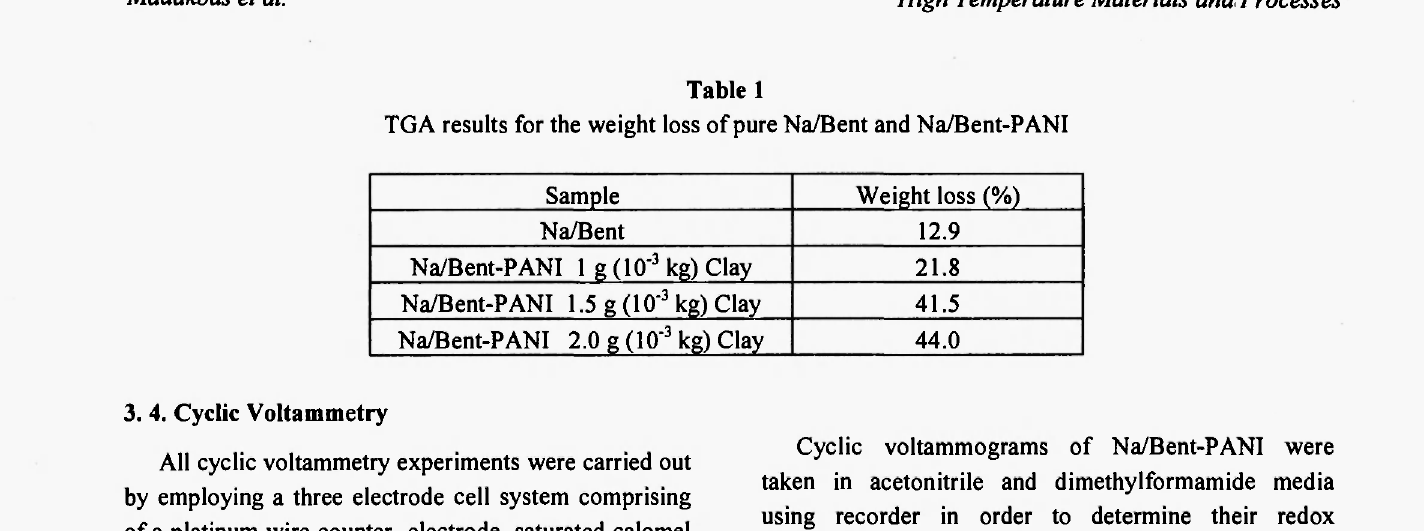
Cyclic voltammograms of Na/Bent-PANI were taken in acetonitrile and dimethylformamide media using recorder in order to determine their redox potentials. 4 shows multiple-cycled voltammograms of the solution recorded in the potential range 0.0 and 1.0 V according to the SCE. All oxidation peaks shifted positively, while the reduction peaks shifted negatively with